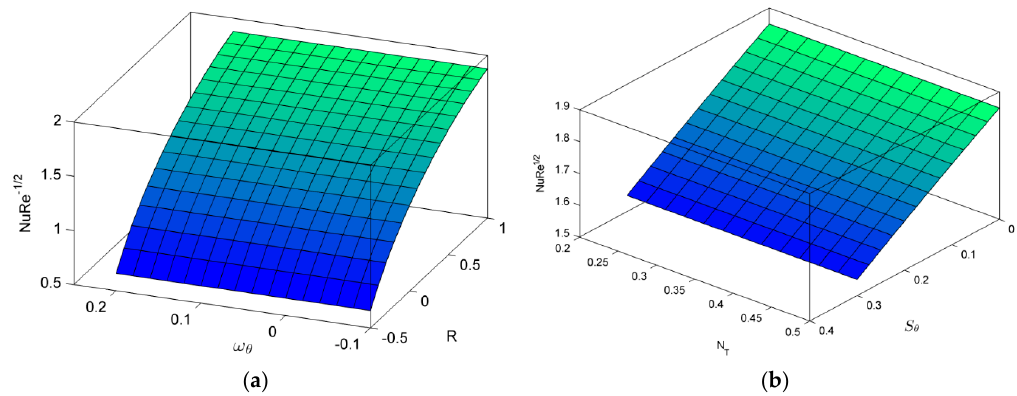
Figure 19. 3D plot of Nusselt number for ( a ) R and ω θ , ( b ) N T and S θ